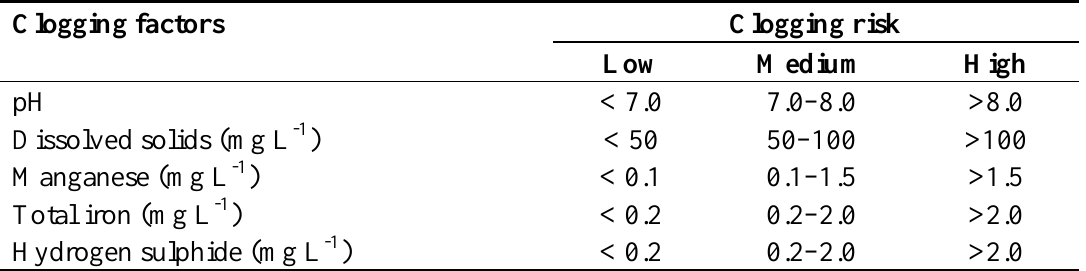
Table 2. Effect of several parameters of irrigation water on clogging risk